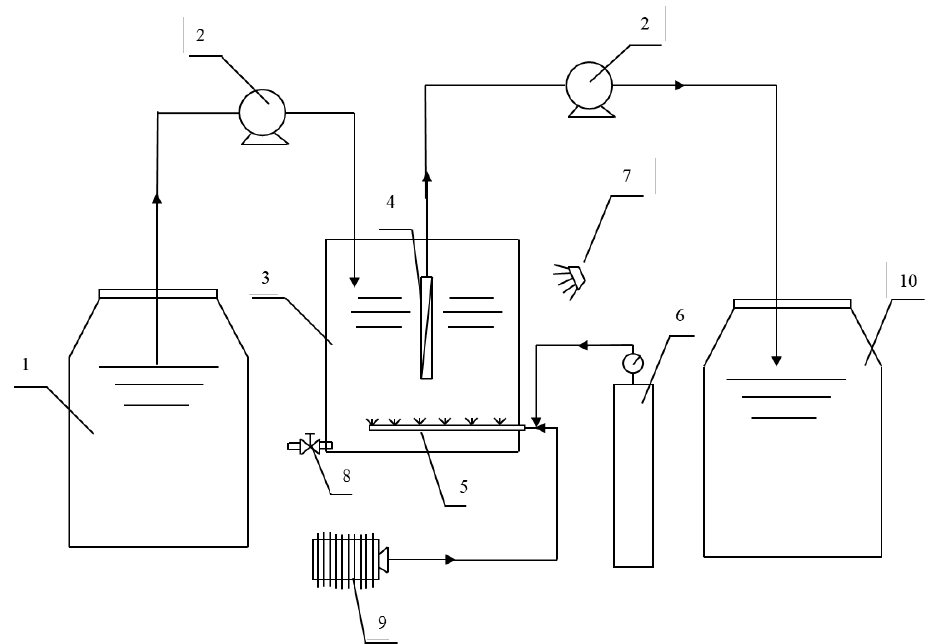
Figure 1. A schematic diagram of the pilot-scale MPBR system. (1)-Primary tank; (2)-peristaltic pumps, (3)-MPBR vessel, (4)-MBR membrane, (5)-air distributor, (6)-CO 2 gas cylinder, (7)-LED lamps, (8)-discharge valve, (9)-Air compressor, (10)-Discharge collector.